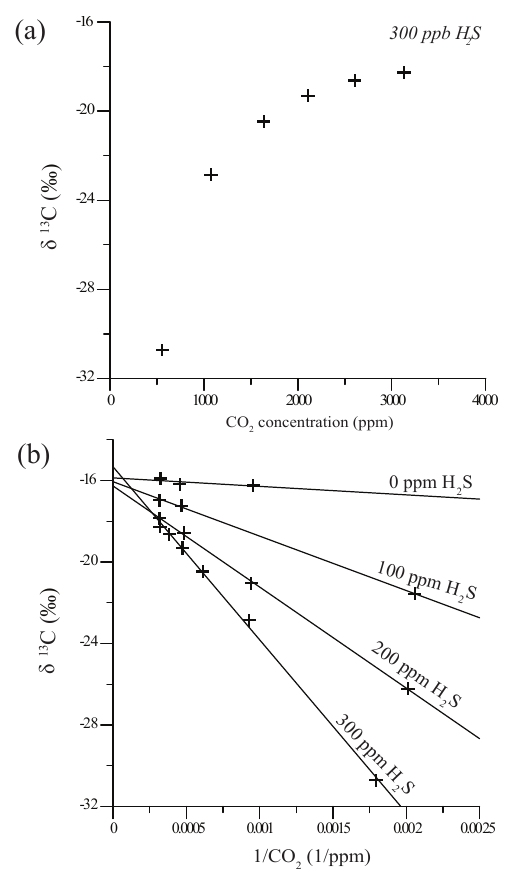
Figure 8. The H 2 S interference is inversely related to the CO 2 concentration. (a) The isotopic signal from the CRDS varies with changing CO 2 concentration when the H 2 S concentration is held constant at 300ppb. (b) Isotopic value vs. 1/CO 2 illustrating the change in δ 13 C with the addition of H 2 S to a standard gas ( − 16.0‰) at different concentrations.